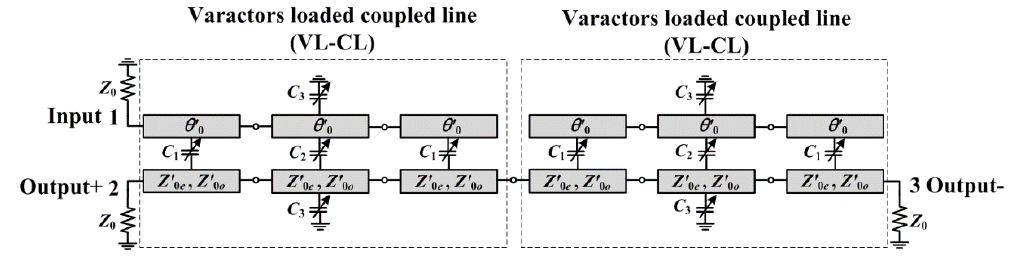
Figure 1. Schematic of the proposed frequency tunable balun.